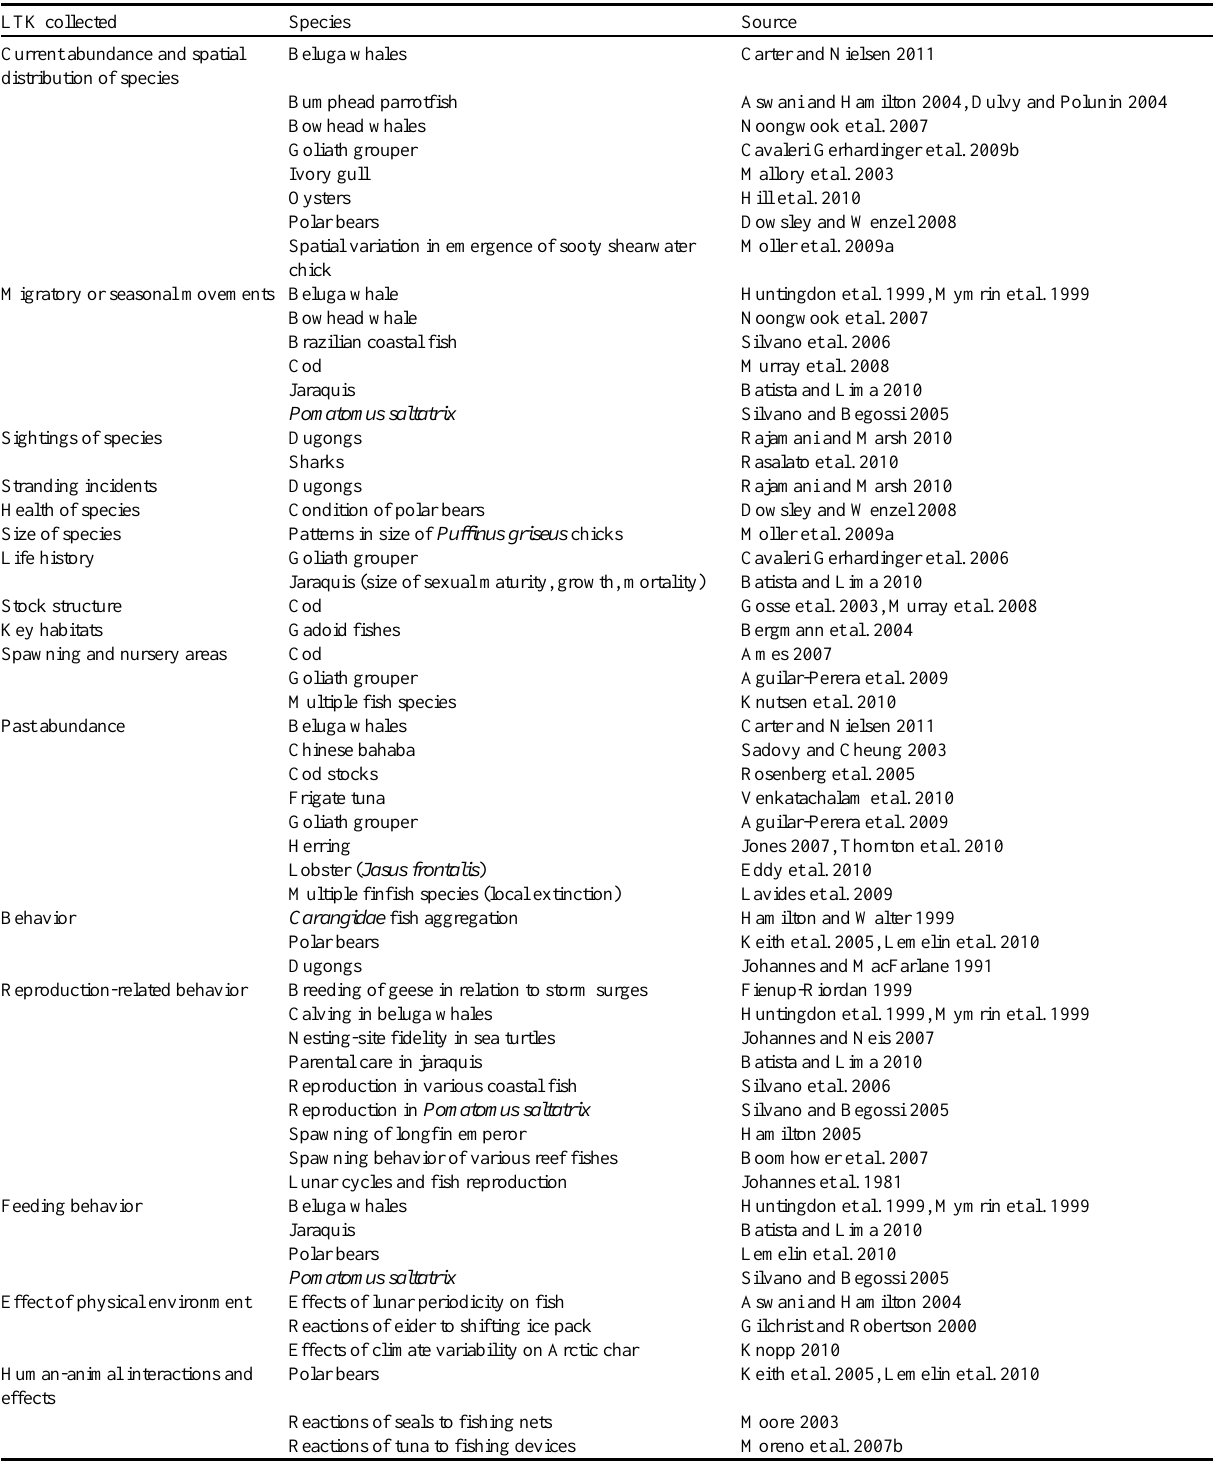
Table 1 . Species-specific